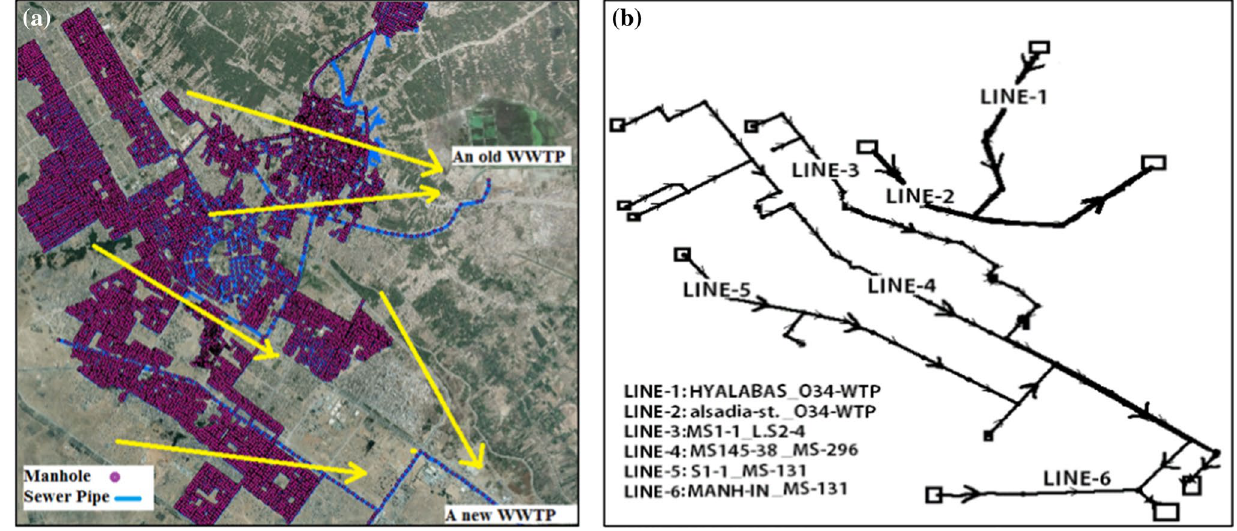
Fig. 2 a The sewer networks in the city center of Karbala (on the left) and b the six main sewer lines in the city center of Karbala (on the